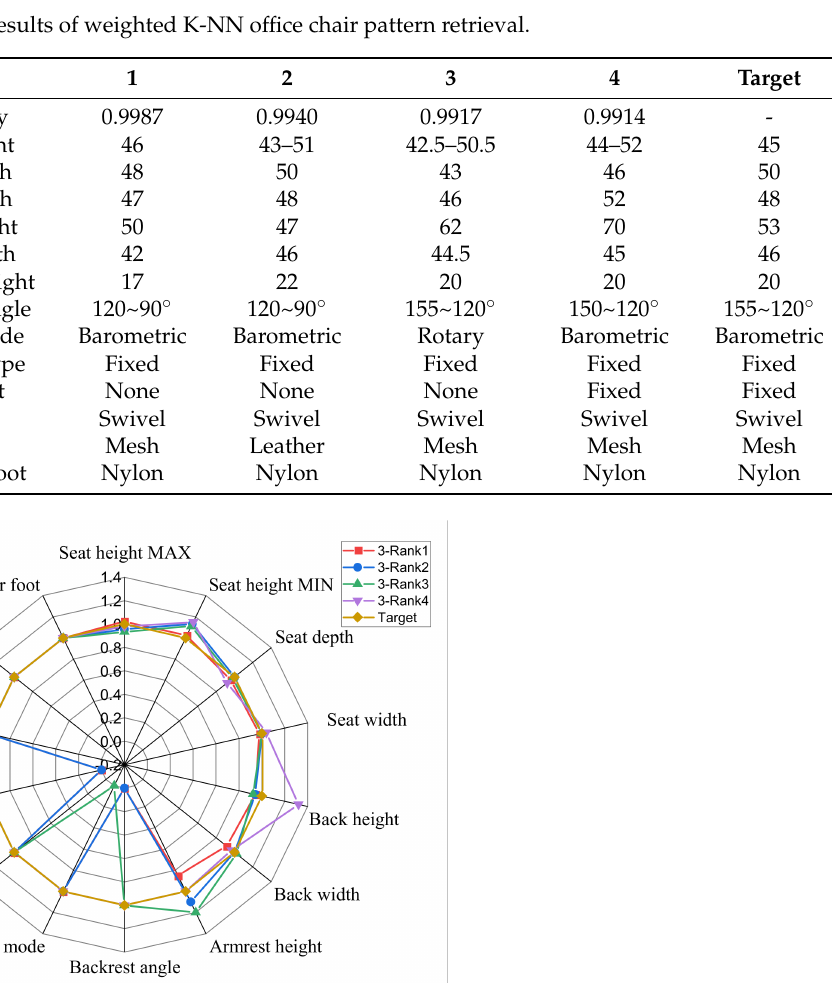
Figure 7. Retrieval results with different